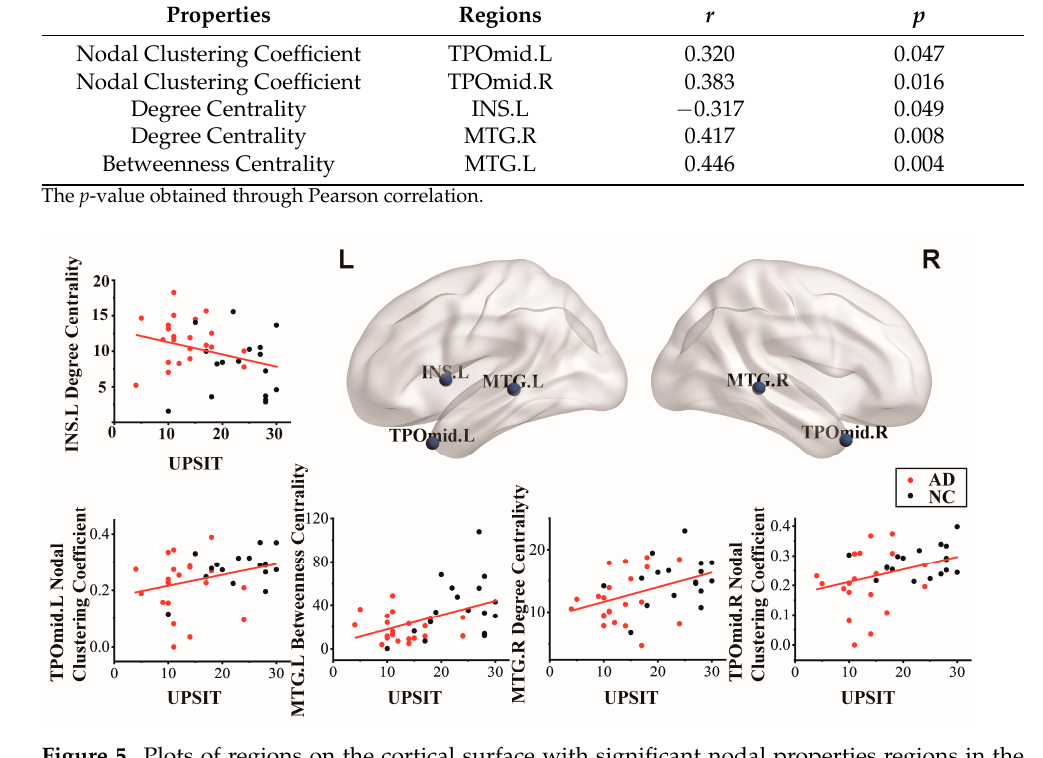
Figure 5. Plots of regions on the cortical surface with significant nodal properties regions in the two groups and University of Pennsylvania Smell Identification Test (UPSIT) scores in the Pearson cor- relation brain region; p < 0.05 was the statistical test analysis result of Pearson